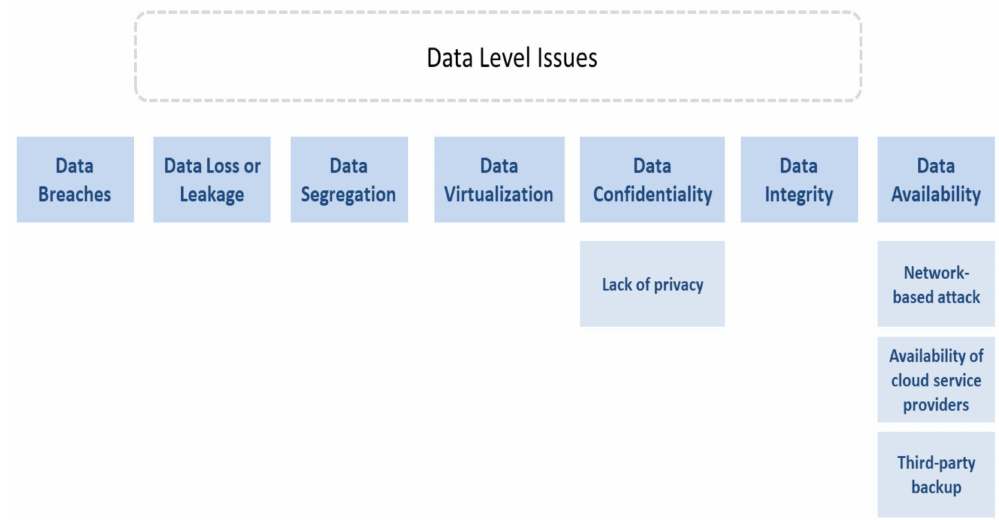
Figure 7. Data Level